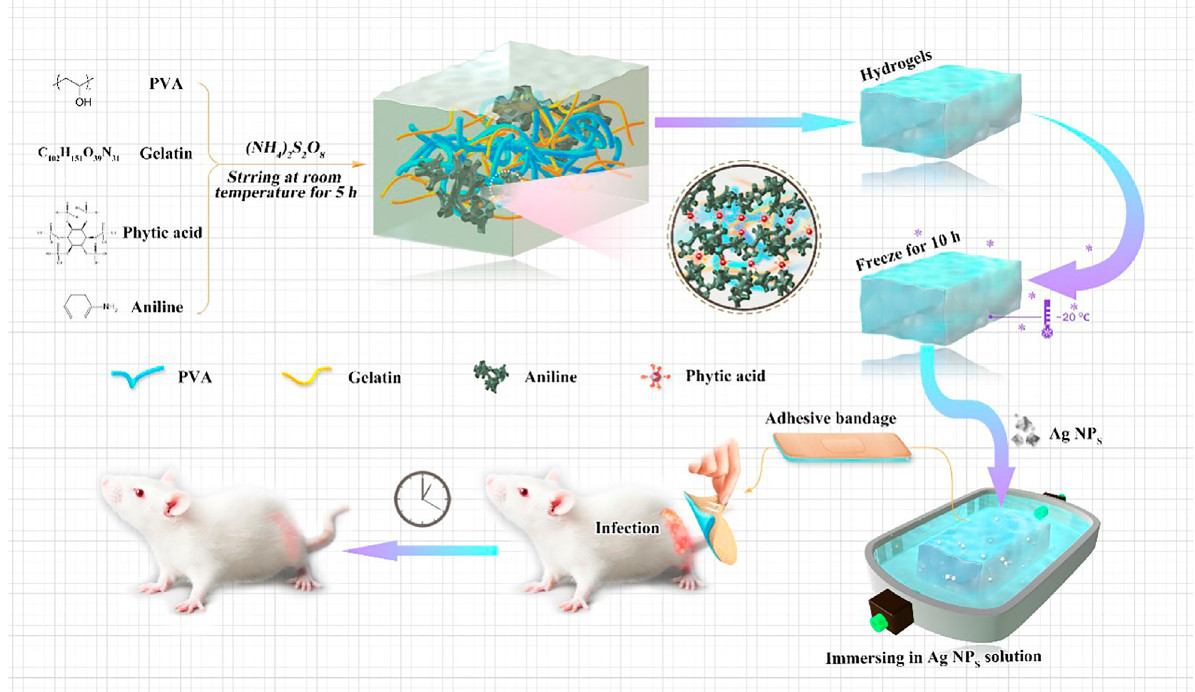
Figure 2. The schematic diagram of the synthesis process of the Ag NPs/CPH, and its applications the animal model. Reproduced with permission